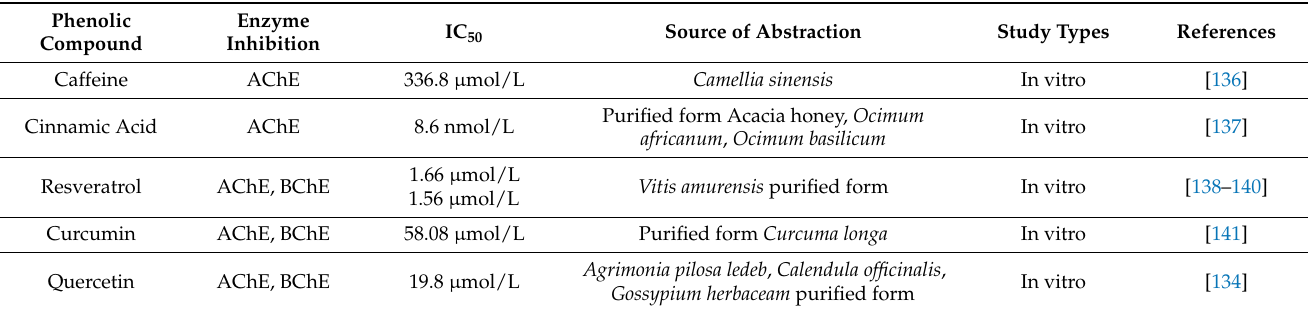
Table 2. Different polyphenols and their modes of action